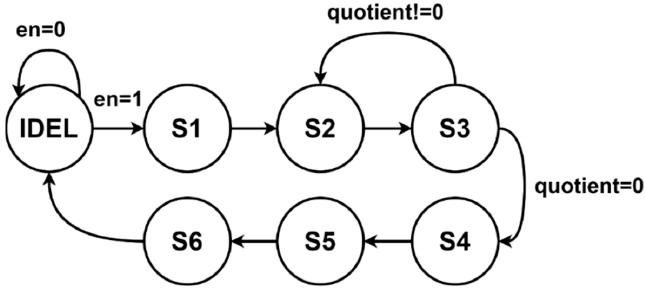
Figure 11. FSM of Golomb–Rice coder module.